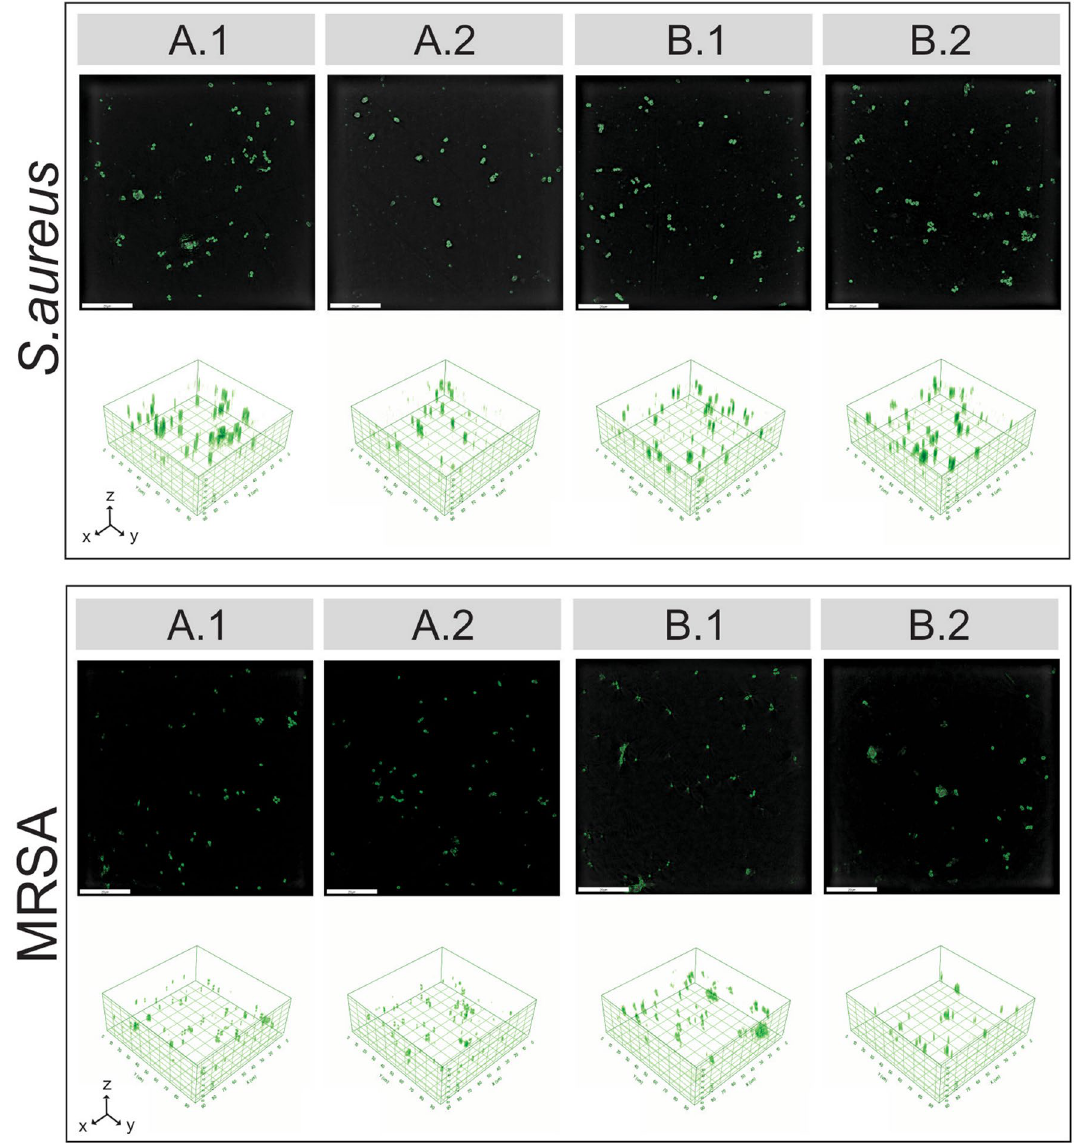
Figure 8. Two-dimensional and three-dimensional topographic microscopy images of S. aureus (top) and MRSA (bottom) attachment onto the multilayered samples containing nisin are displayed in the top and bottom rows, respectively. A: PEM with nisin outer layer and; B: PEM with nisin/CAR outer layer. Numbers represent different samples of the same type. Scale bar = 20 µm. Note: green indicates both live and dead